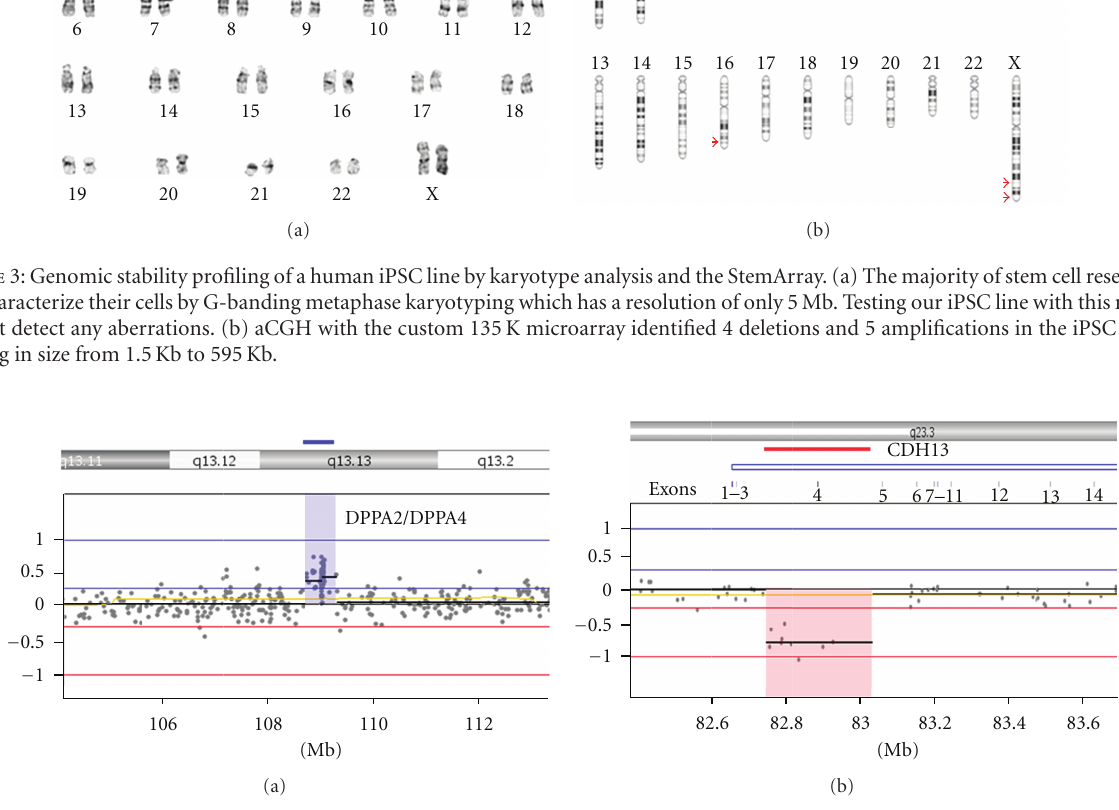
Figure 4: The stem-cell-targeted 135 K StemArray can detect causative aberrations in iPSC lines known to influence cell survival and proliferation. Detection of two acquired chromosomal abnormalities in stem-cell-associated and cancer-related genes in an iPSC line. (a) A 595Kb amplification spanning the stem-cell-related DPPA2 and DPPA4 genes, and (b) a 285 Kb deletion covering exons 4-5 of the cancer associated CDH13